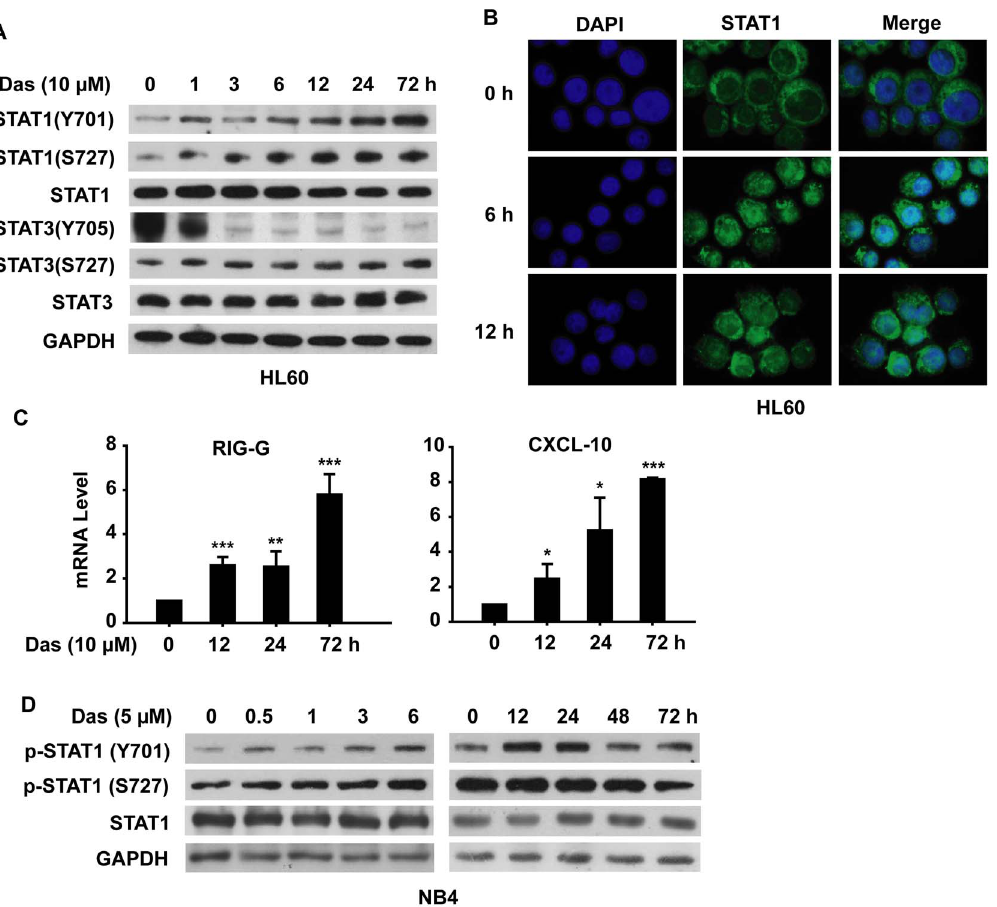
Figure 3. Dasatinib induces activation of STAT1. HL60 cells were treated with dasatinib (10 m M) for the indicated times. (A) Whole cell lysates were analyzed by SDS-PAGE followed by Western blotting using specific antibodies. The experiments were repeated three times and the data show the representative results. (B) Representative fluorescence microphotographs showed a translocation of STAT1 from cytoplasm to nucleus. Original magnification, 6 63. The results are representative of three independent experiments. (C) The expression of CXCL-10 and RIG-G and IRF-1 mRNA was determined by real-time quantitative PCR. The expression of GAPDH was used as the internal control gene. Shown are fold increases over untreated cells. Data presented are the mean 6 SD of three independent experiments. *** P , .001, ** P , .01, * P , .05 versus untreated cells. (D) NB4 cells were treated with dasatinib (5 m M) for the indicated times. The level of p-STAT1 (Y701), p-STAT1 (S727), STAT1 and GAPDH proteins was determined by Western blotting analysis. The results are representative of three independent